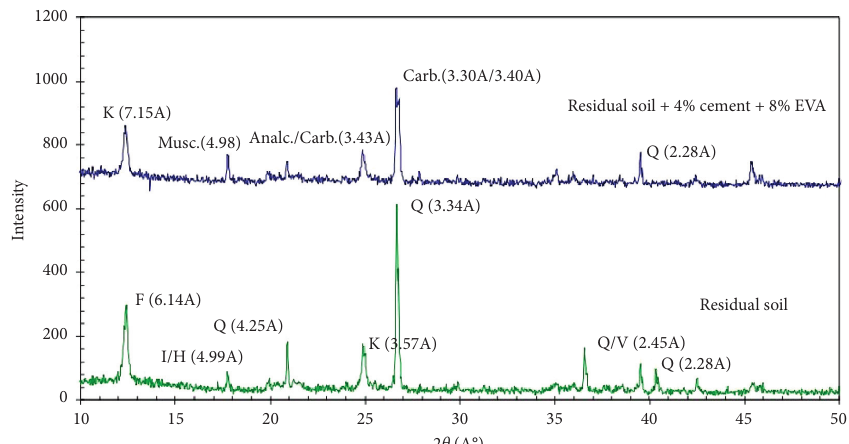
Figure 9: Diffractogram analysis of stabilized soil cured for 7 days.